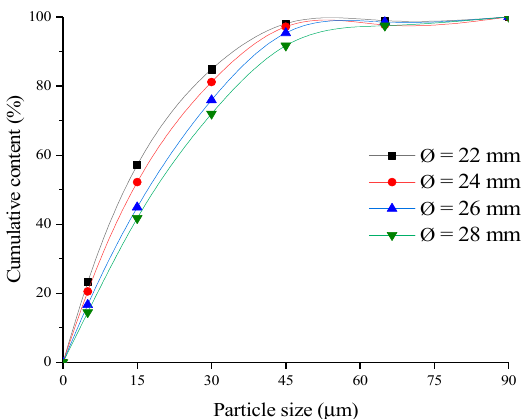
Figure 7. Effect of internal vortex finder diameter on internal overflow particle size.